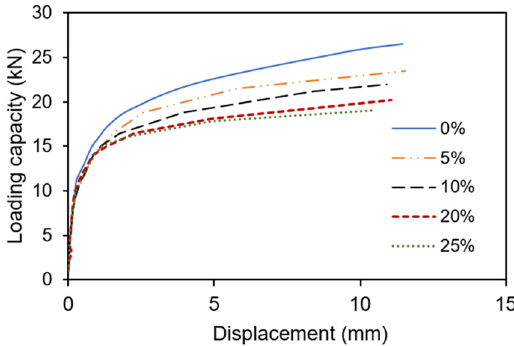
Figure 17: Comparisons between experimental data and FE model.